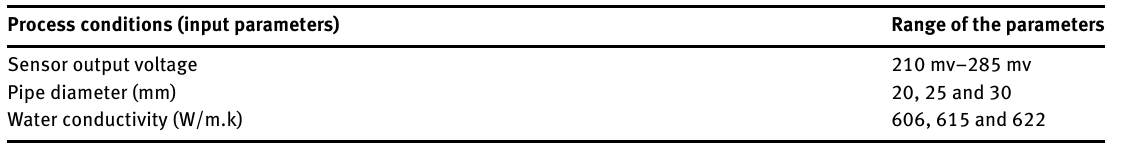
Table 2: Ranges of the Process Parameters.